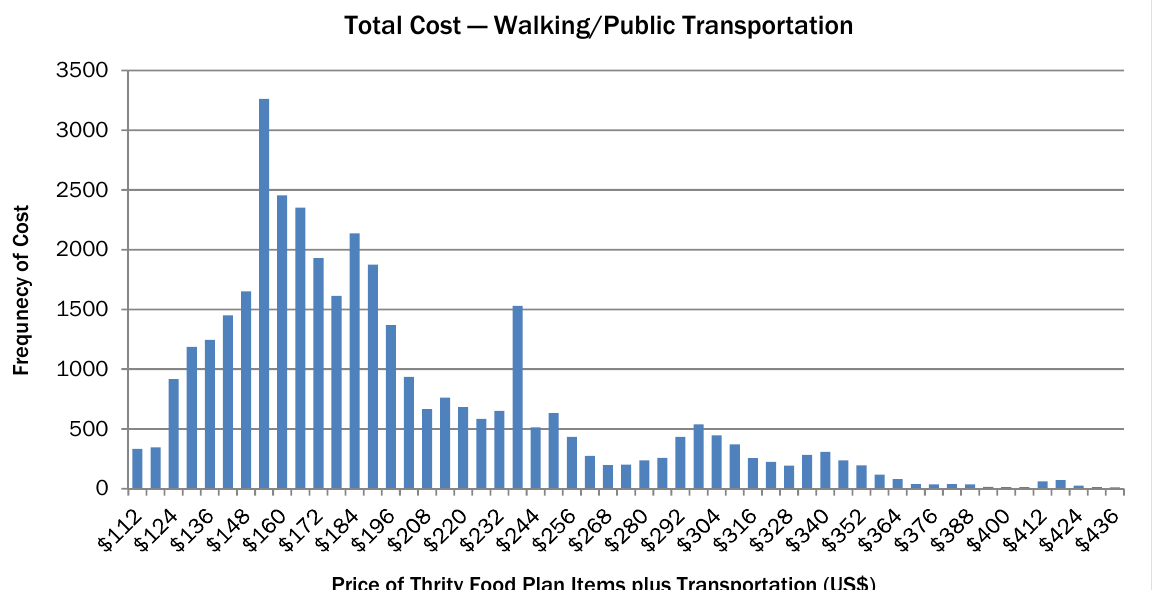
Figure 3. Variation in total cost of the USDA Thrifty Food Plan in the Gulf Coast counties of Mississippi, during spring 2011, including both the cost of the food items and transportation to acquire them, assuming that all items are purchased and the shopper uses a combination of walking and public transportation by bus to achieve the lowest cost for the combination of food price and travel.